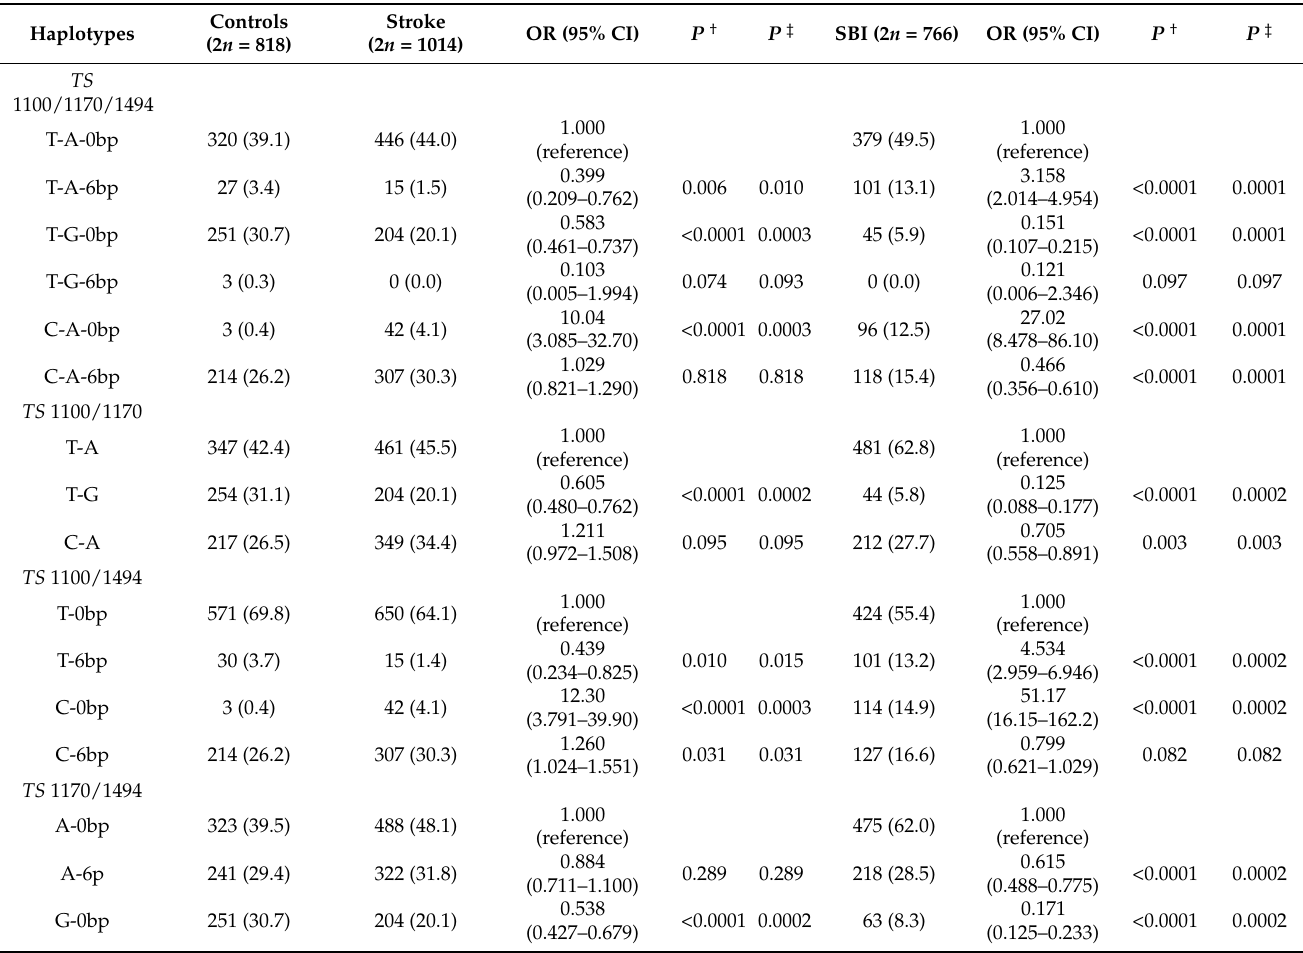
Table 3. Haplotype analysis of the TS gene polymorphisms in control subjects, ischemic stroke patients, and silent brain infarction